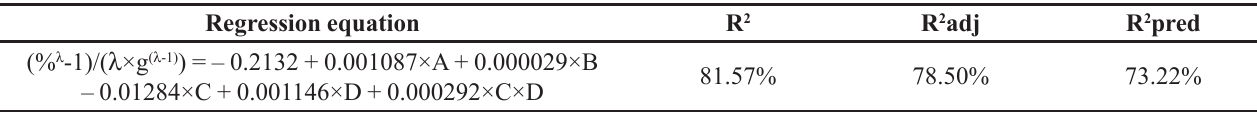
TABLE II - Regression equation and coefficients of determination (R 2 , R 2 adj, and R 2 pred) of the amount of acetaminophen dissolved (%) as a function of time of dissolution (A), volume of dissolution media (B), pH of dissolution media (C), and rotation speed (D) Regression